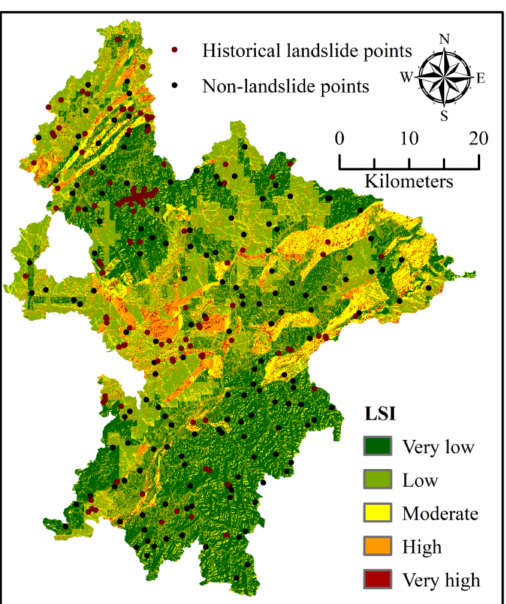
Figure 7. Landslide susceptibility index (LSI) of the study area and distribution of the non- landslide